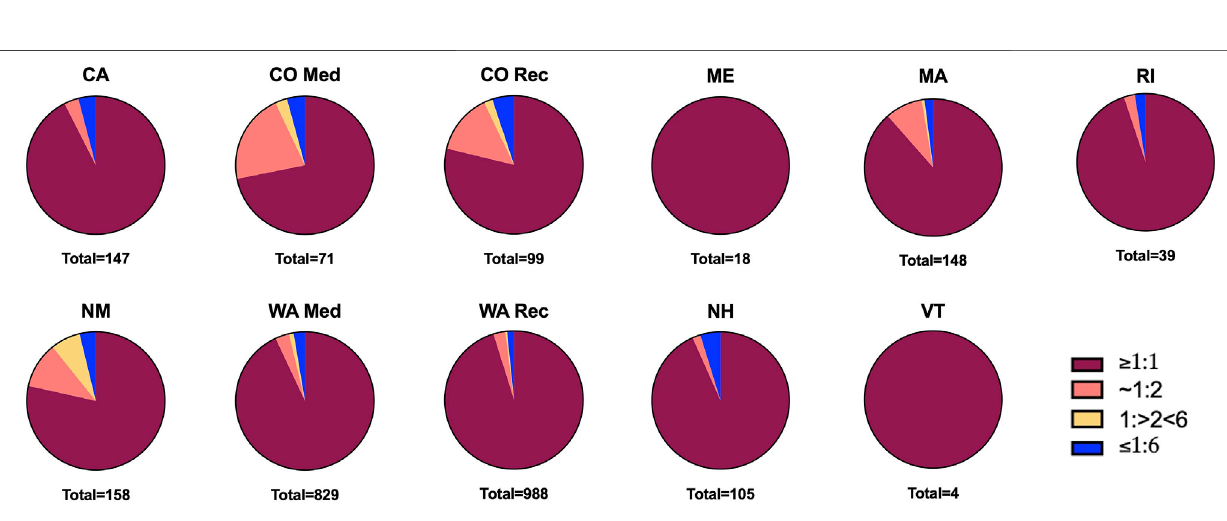
Frontiers in Pharmacology |